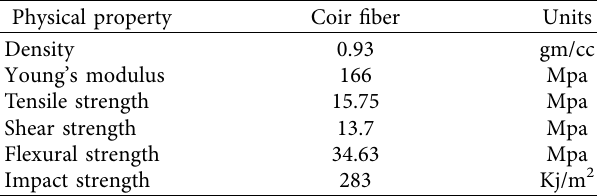
Table 1: The coir fiber’s physical